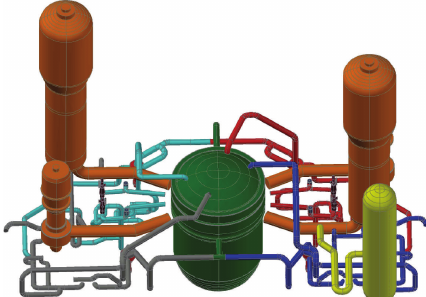
Figure 1: Schematic representation of Atucha II primary circuit showing the RPV, steam generators, main pumps, and the pres- suriser.